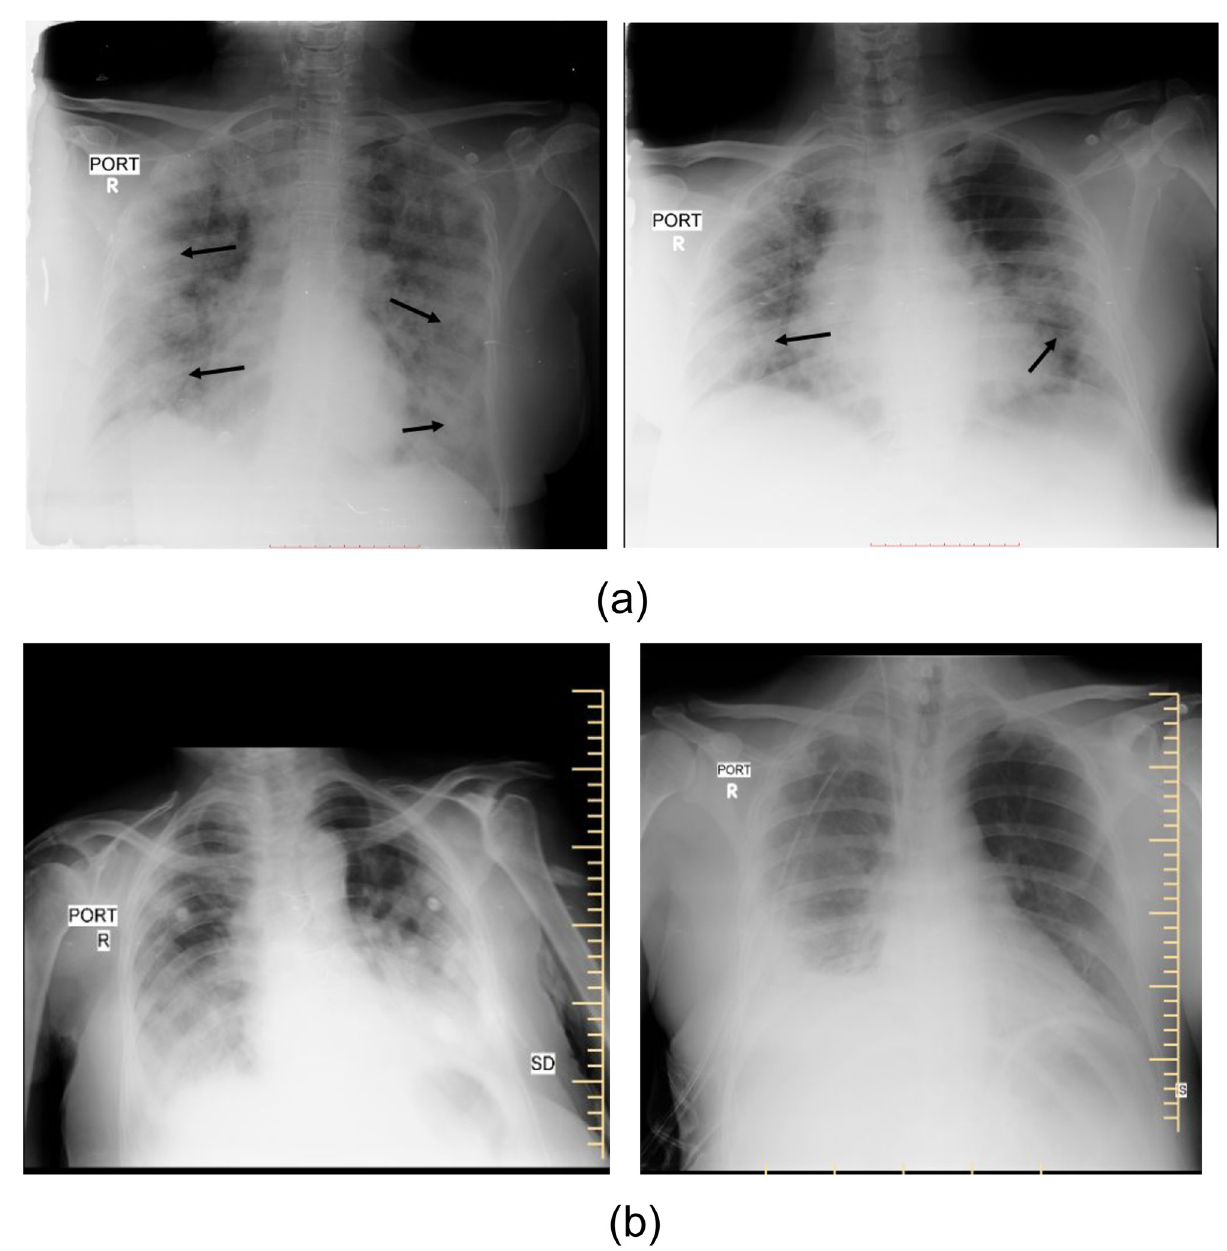
Fig 1. Chest X-rays of (a) RT-PCR proven COVID-19 pneumonia in cases showing the typical bilateral peripheral consolidations and ground-glass opacities. (b) Non-COVID-19 pneumonia in cases showing the lobar distribution of consolidations with pleural effusion.